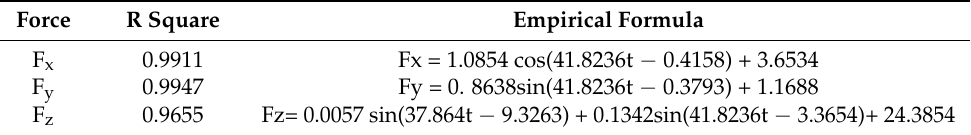
Table 2. The fit results of three-dimensional force with rotational speed of 400 rpm and welding speed of 200 mm/min.